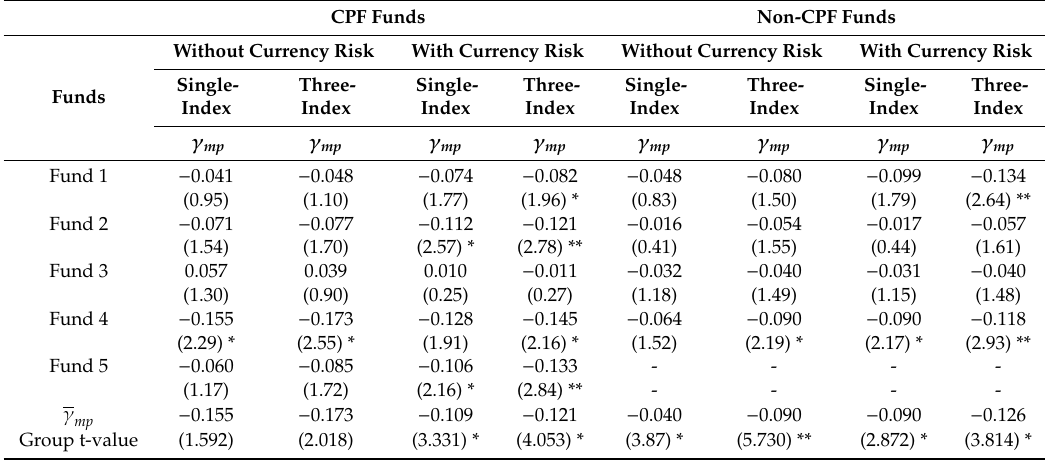
Table 5. Volatility-timing coe ffi cients for Japan equity funds under the CPF Investment Scheme and non-CPF funds.